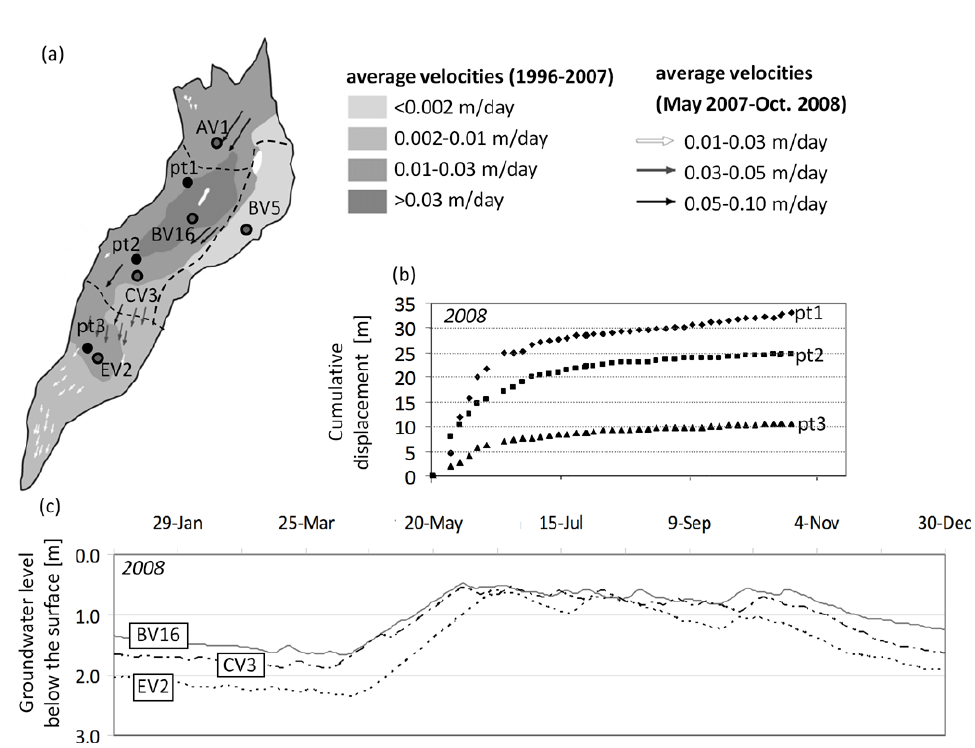
Fig. 3. (a) Horizontal surface displacement observed between May 2007 and October 2008 based on ortho-photo analysis (Niethammer et al., 2012) and long-term average movement velocity map (1996–2007) as reported by Malet et al. (2003); note the location of the piezometers, measurements points of displacement and the hydro-geomorphological units; (b) cumulated displacement measured at three points: pt1, pt2 and pt3 (Travelletti et al., 2012); (c) groundwater level fluctuation observed at three piezometers (BV16, CV3, EV2) between May 2008 and November 2008.